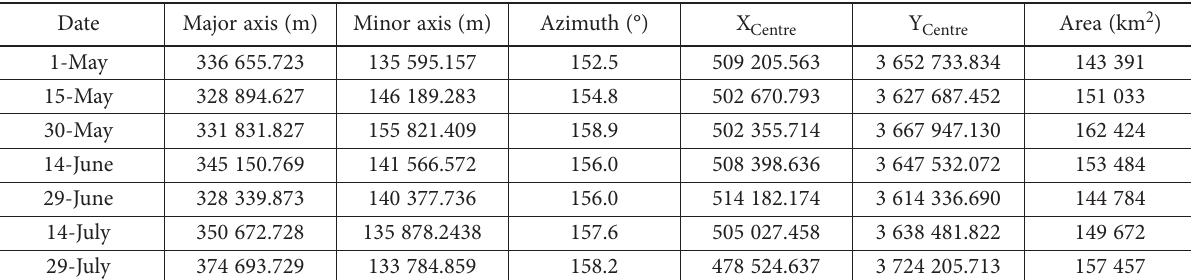
Table 3. Standard dviational ellipse parameters of COVID-19